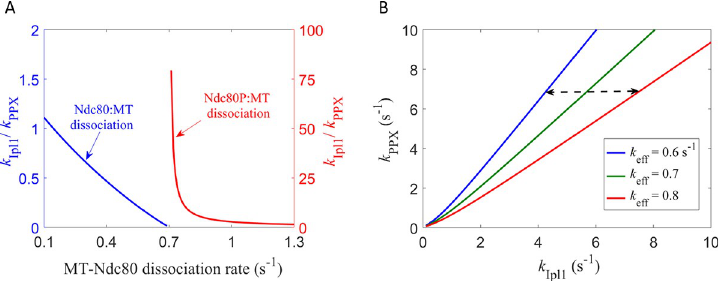
Fig 8. Dependence of kinase-phosphatase balance point on MT-Ndc80 dissociation rates. (A) The blue curve corresponds to variation in the Ndc80:MT dissociation rate when the Ndc80P:MT dissociation rate is fixed at 1.5 s − 1 . As the Ndc80:MT dissociation rate is increased towards the optimal value of k d,eff (0.7 s − 1 ), the balance point drops to zero. The red curve corresponds to variation in the Ndc80P:MT dissociation rate, when the Ndc80:MT dissociation rate is fixed at 0.1 s − 1 . As the Ndc80P:MT dissociation rate is decreased towards optimal k d,eff , the balance point becomes much larger than one. (B) Curves on which the effective MT-Ndc80 dissociation rate k eff is constant. The curves were calculated using Eq 3. At a fixed value of k PPX , the interval between the red and the blue curves is the range of k Ipl1 over which the biorientation probability is high (see Fig 5). This range increases with increasing k PPX .